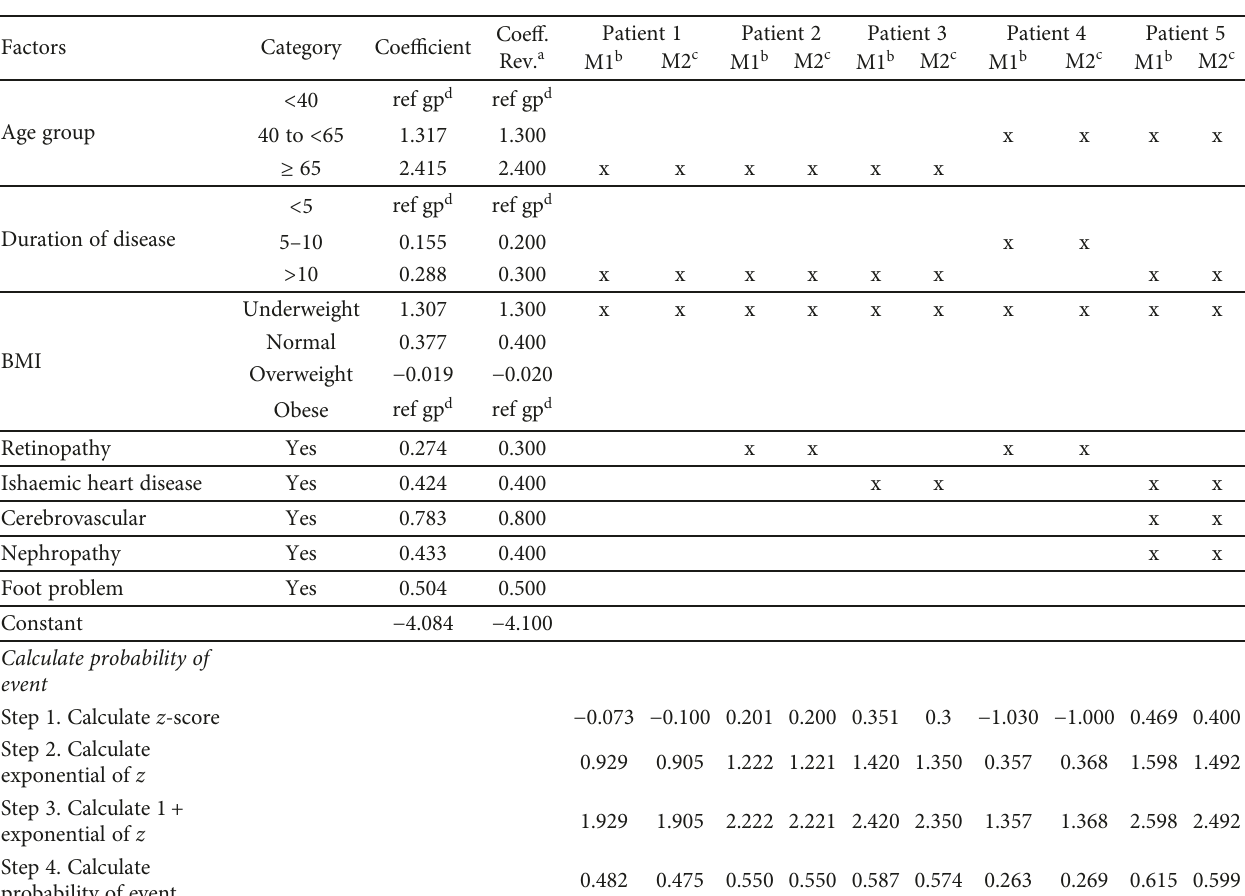
Table 4: The examples in calculating the probability of event based on the coe ffi cients in the model 3. Factors